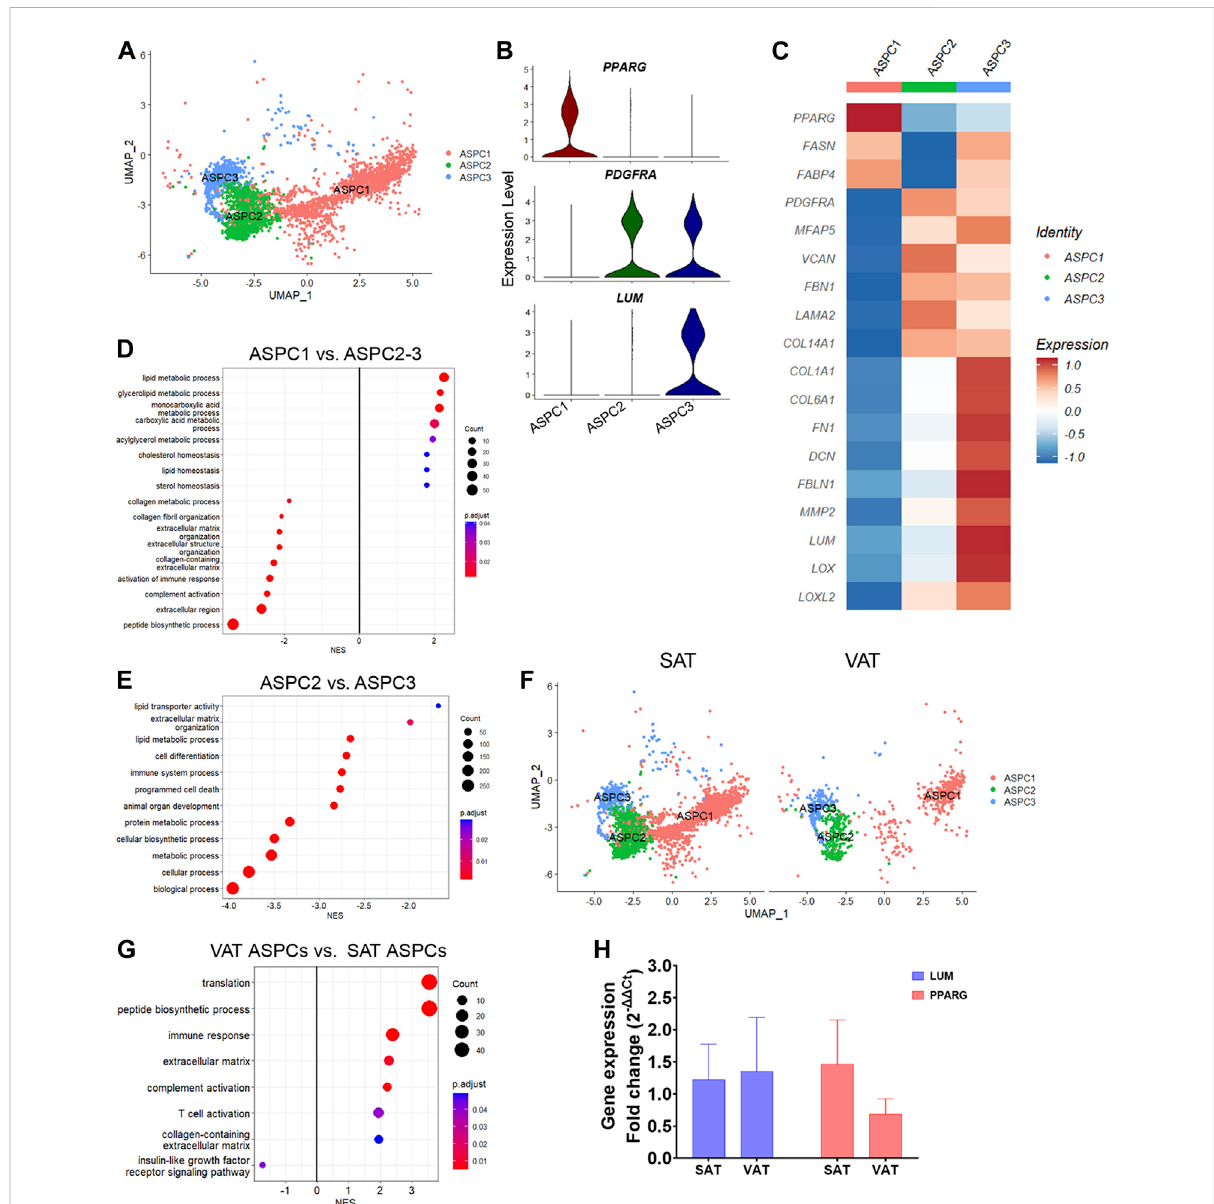
FIGURE 3 Transcriptional diversity of adipose stem and progenitor cells (ASPC) in visceral (VAT) and subcutaneous (SAT) adipose tissue of dairy cows. (A) UMAP plot of ASPCs across SAT and VAT. (B) Violin plots of ASPC markers PPARG, PDGFRA , and LUM in the distinct ASPC subtypes. The y axis indicateslog-transformedexpressionvalues,andthewidthindicatesthenumberofcellsexpressingthegene. (C) HeatmapofASPCmarkersgenesin the distinct identi fi ed subtypes. Color encodes the scaled average expression level across those cells (high expression; blue: downregulation). (D) Pathway analysis (GSEA) of differentially expressed genes (DEG) between adipogenic ASPC1 and FAP ASPC2/3. Positive normalized enrichment score (NES) represents pathway activation on ASPC1, while a negative NES represents pathway suppression when compared with ASPC2-3. (E) Pathway analysis (GSEA) of differentially expressed genes between FAP ASPC2 and FAP ASPC3. Positive normalized enrichment score (NES) represents pathway activation on ASPC2, while a negative NES represents pathway suppression when compared with ASPC3. (F) UMAP plots of VAT and SAT ASPCs. (G) Pathway analysis (GSEA) of differentially expressed genes between overall VAT and SAT ASPC types. Positive normalized enrichment score (NES) represents pathway activation on VAT ASPCs, while a negative NES represents pathway suppression when compared with SAT ASPCs. (H) Comparison of adipocyte relative to preadipocyte gene expression fold change of LUM and PPARG between SAT and VAT obtained from an independent cohort of dairy cows (n = 4). For gene expression fold change calculations, adipocyte PPARG and LUM expression were calibrated by preadipocyte expression in matched SAT and VAT samples from each